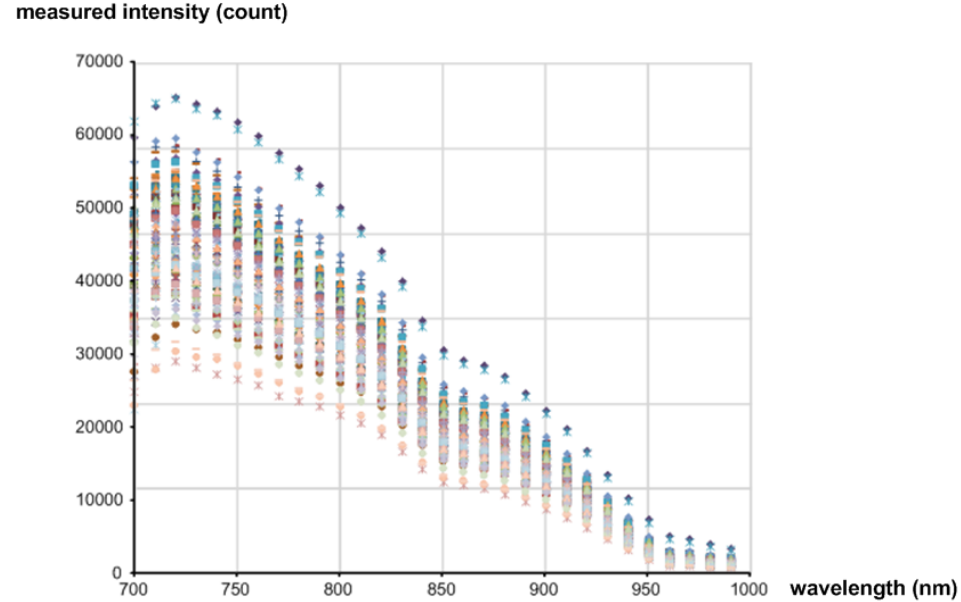
Figure 3. Measured intensities of diffuse reflected NIR light coming from all the samples.